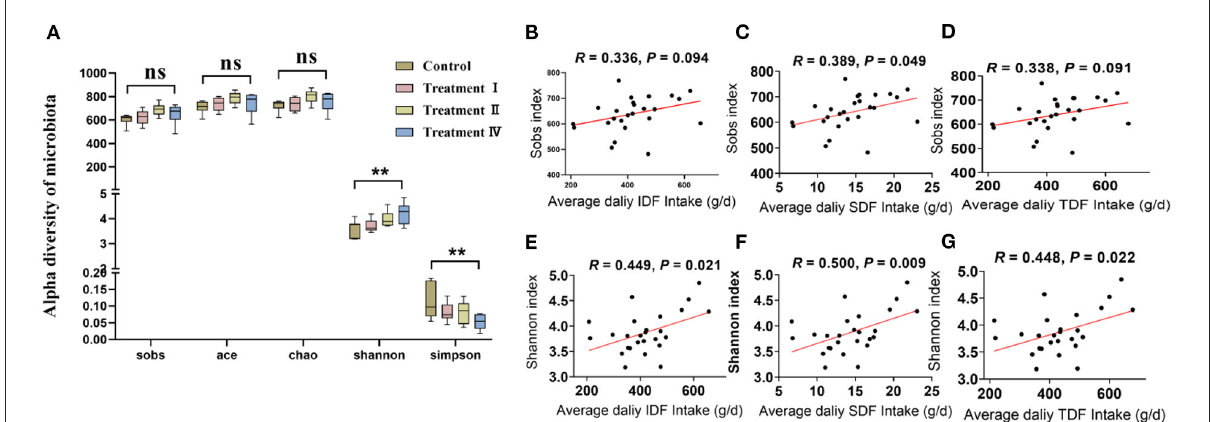
FIGURE2 Comparison of microbial community between treatment groups and the control group. Alpha diversity of microbial communities (A) . Spearman’s correlation between Sobs index with insoluble dietary fiber (B) , soluble dietary fiber (C) and total dietary fiber (D) , respectively. Spearman’s correlation between Shannon index with insoluble dietary fiber (E) , soluble dietary fiber (F) , and total dietary fiber (G) , respectively. One-way ANOVA followed by LSD post-hoc test was conducted. * p < 0.05, ** p < 0.01, ns, not significant.